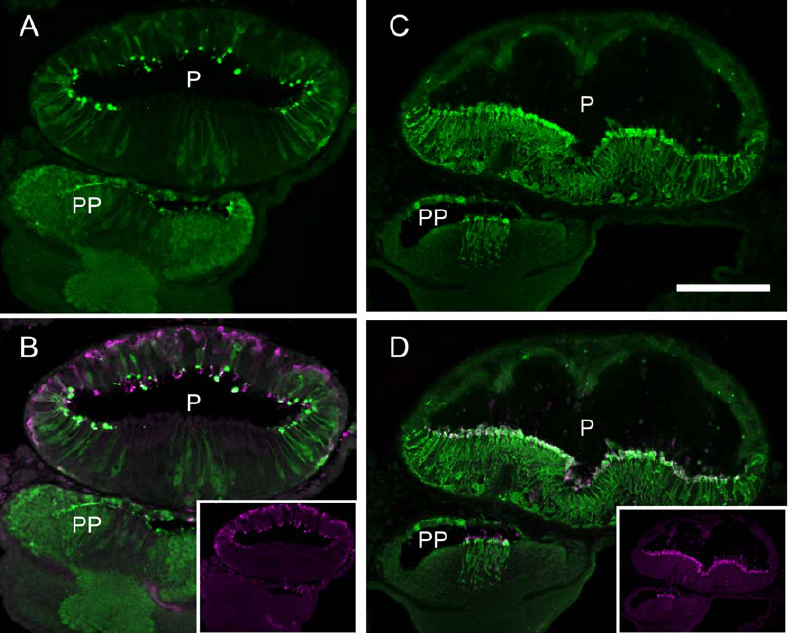
Figure 2. Localization of arrestins in the lamprey pineal organ. A: Immunoreactivity to lamprey b -arrestin (green); B: merged image of immunoreactivity to b -arrestin (A) and parapinopsin (inset, magenta); C: immunoreactivity to lamprey visual arrestin (green) and D: merged image of immunoreactivity to visual arrestin (C) and rhodopsin (inset, magenta). b -arrestin is localized to the dorsal photoreceptor cells (A), whereas lamprey visual arrestin is localized to the ventral photoreceptor cells (C). P, pineal organ; PP, parapineal organ. Scale bar, 100 m m.